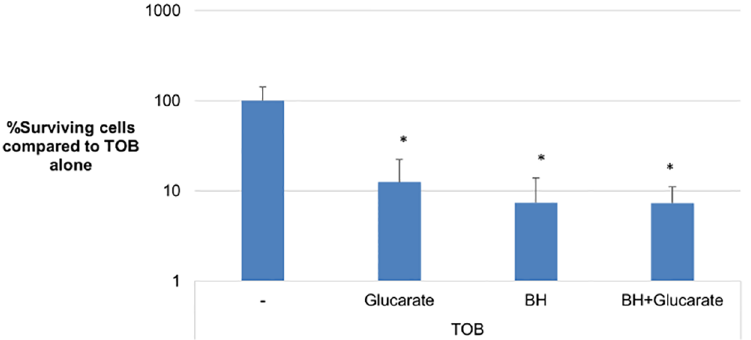
Fig 8. Impact of glucarate and BH on the susceptibility of B . cenocepacia J2315 biofilms towards TOB. Data shown are the percentage surviving cells compared to TOB treatment alone. (cid:3) : significantly less surviving cells compared to TOB alone (p < 0.05). Error bars show SD (n =